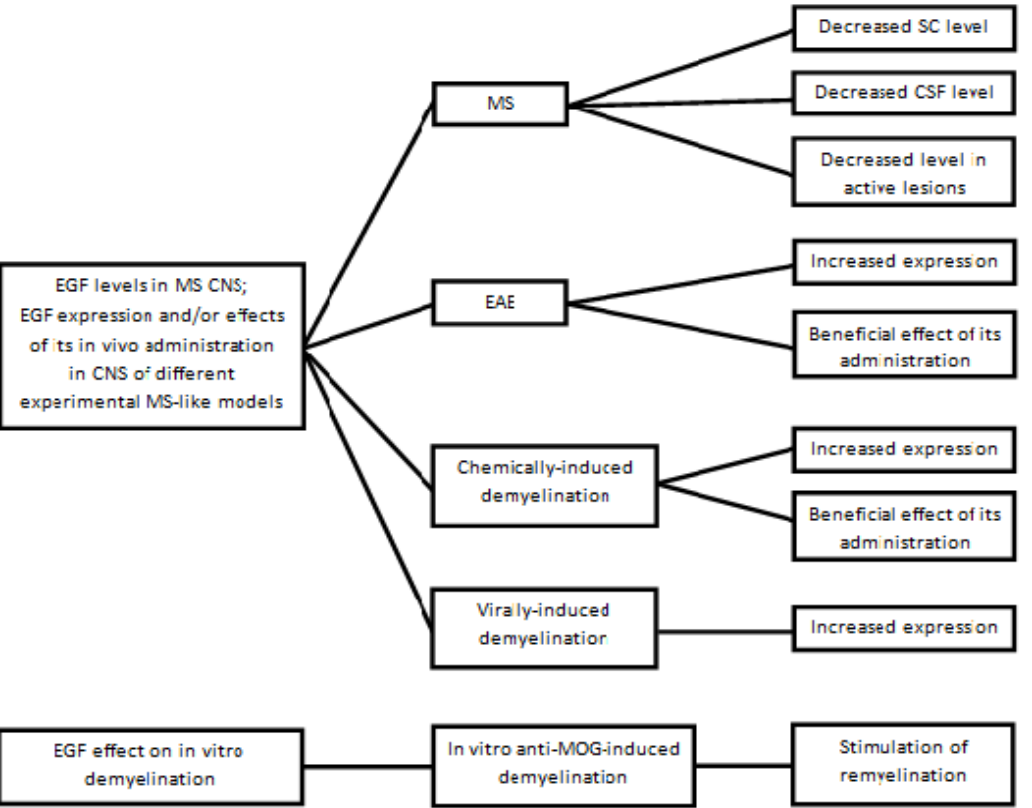
Figure 3. Schematic diagram of the epidermal growth factor (EGF) levels in multiple sclerosis (MS) central nervous system (CNS), EGF expression, and the effects of its in vivo or in vitro administration in different models of experimental allergic encephalomyelitis (EAE) and chemically or virally-induces CNS demyelination. See the text for details and references. CSF = cerebrospinal fluid; MPG = myelin oligodendrocyte-specific glycoprotein.